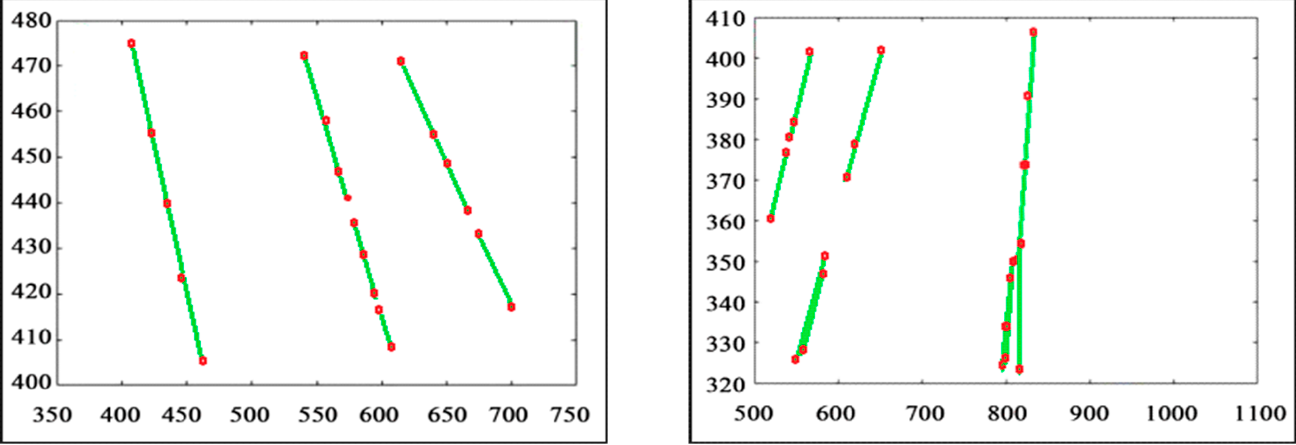
Figure 11. Road line